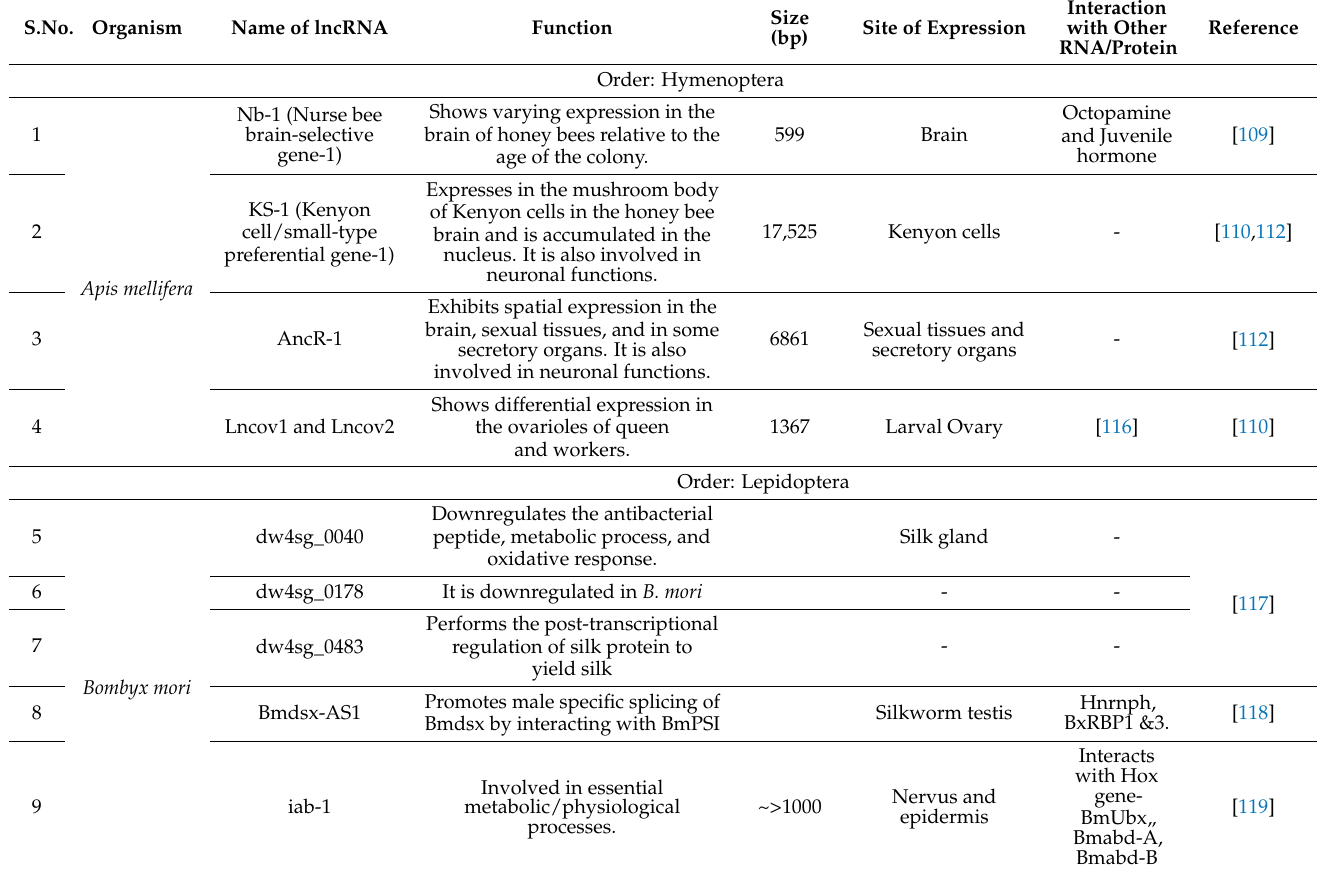
Table 1. Table summarizing the important lncRNAs in different insect orders (Figure